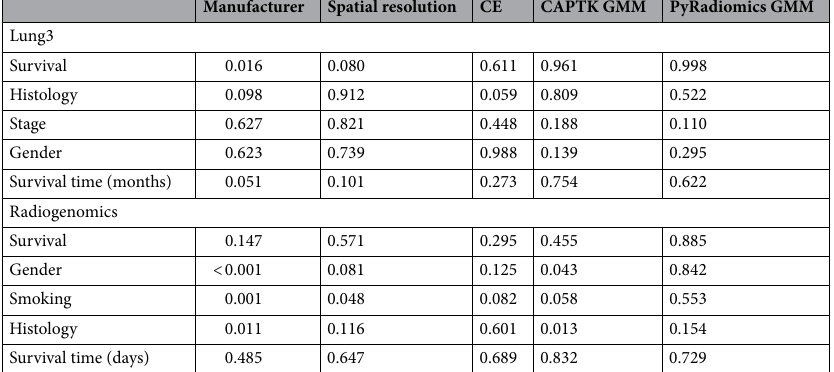
Table 4. P values from the chi-squared test for independence (between categorical variables) and point biserial correlation test (between categorical and continuous variables) to detect association between clinical variables and imaging parameters, as well as GMM groupings. Red fill indicates p values below the 0.05 threshold for